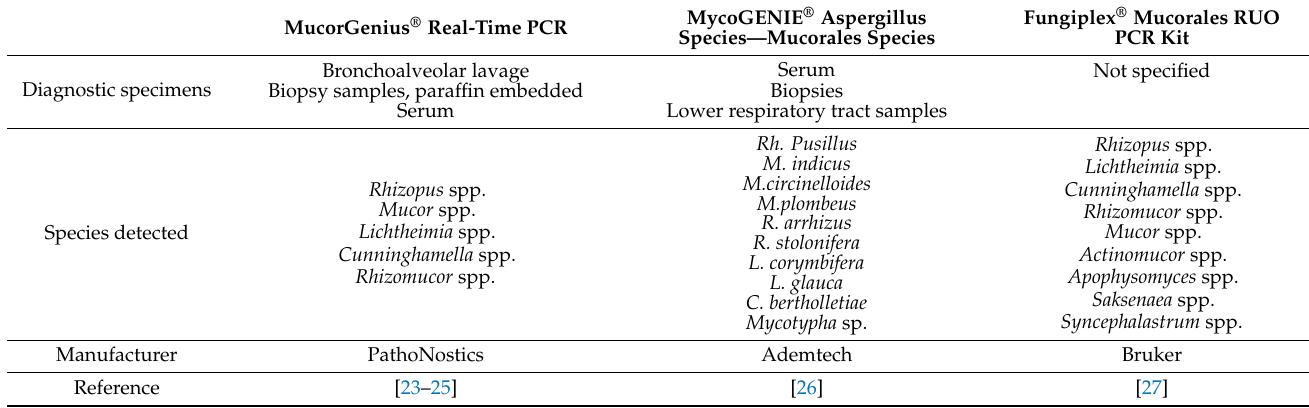
Table 1. Available commercial methods for molecular diagnosis of